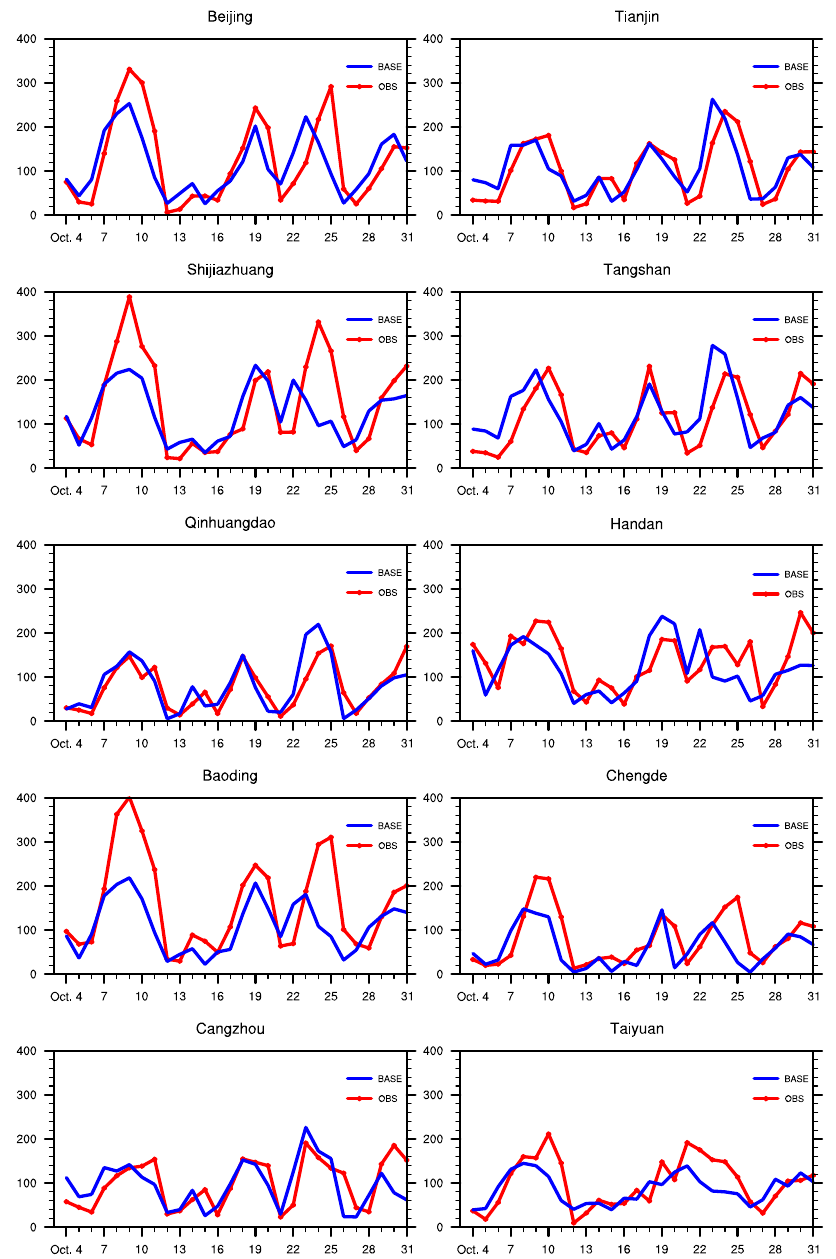
Figure 4. Time series of observed 24h averaged PM 2 . 5 concentrations (µgm − 3 ) at 10 national monitoring system sites in the NCP (locations as black dots in Fig. 1), along with the results from the BASE